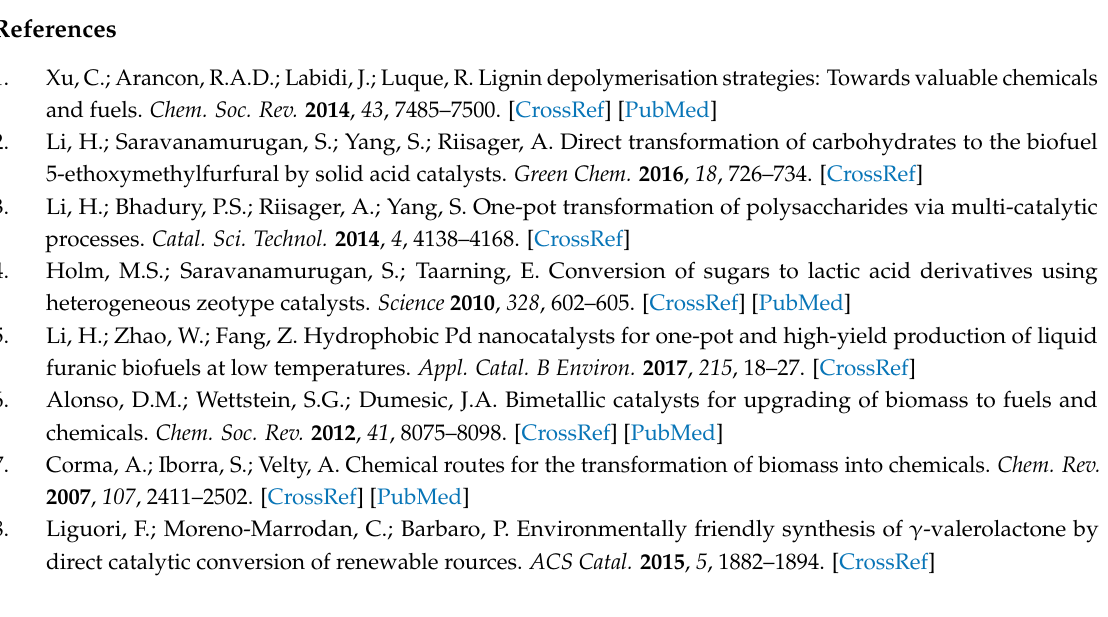
Table S1. Quantitative analysis data of chemical adsorption. Table S2. Percentage of atomic concentration on the catalyst surface by XPS. Figure S1. Pore diameter of HfO2 and recovered PPOA-Hf-1:1.5. Figure S2. STEM image and elemental mappings of PPOA-Hf-1:1.5. Figure S3. XPS spectra of in PPOA-Hf-x with different PPOA/Hf molar